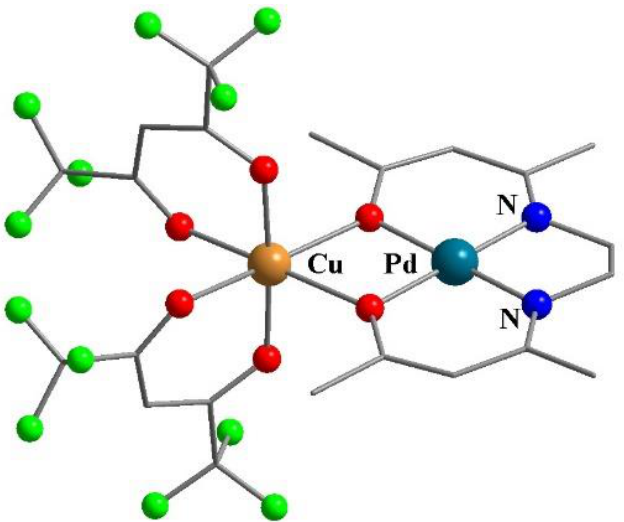
Figure 34. Molecular structure of 67 [105]. The cif has been retrieved from CCDC. CCDC number is